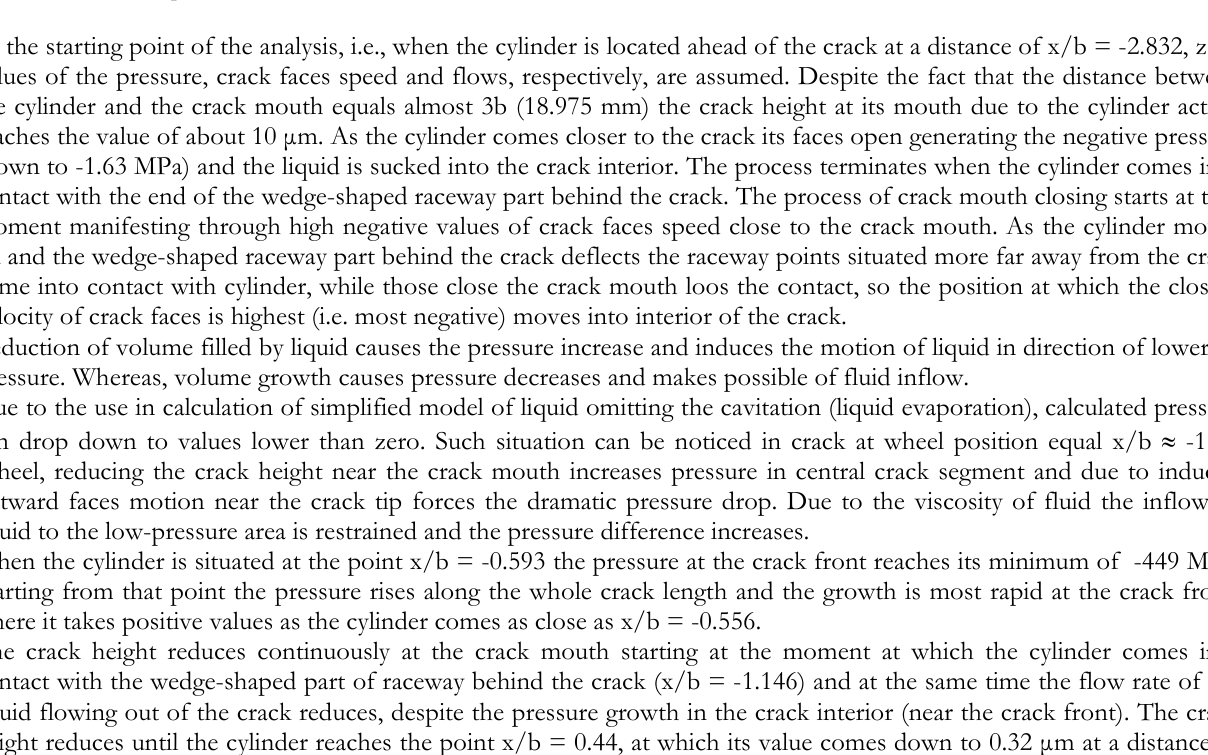
Figure 6: Distributions of: a) pressure (p); b) crack height (h); c) crack faces velocity (v); d) flow rate (Q), respectively, along the crack (s) for different load positions